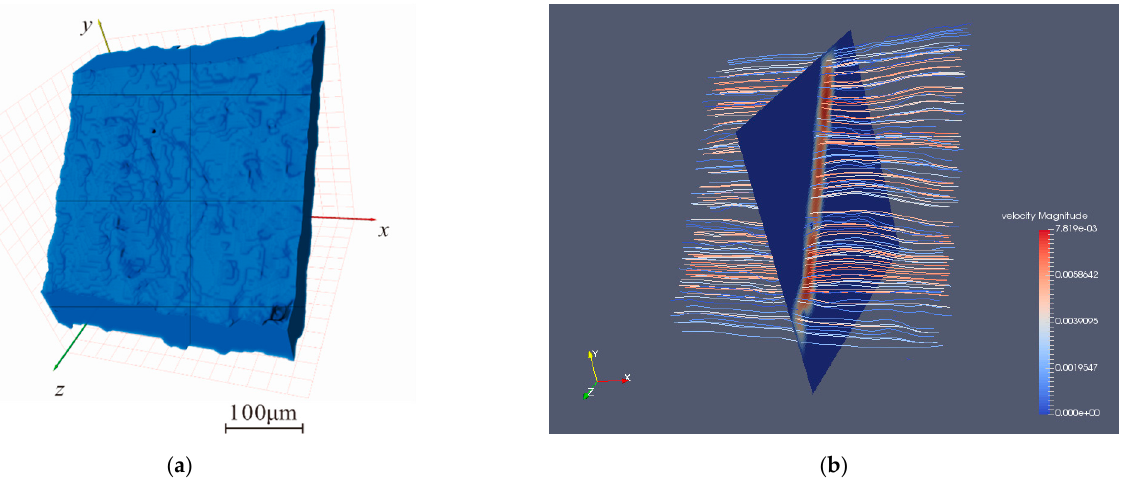
Figure 12. The digital core and streamlines of the first 0 MPa: ( a ) the digital core, ( b ) the streamlines. The digital core and streamlines of the first 0 MPa are shown in Figure 12. Based on the data simulated by LBM, the relationship between fracture permeability and cyclic effective stress can be obtained, as shown in Figure